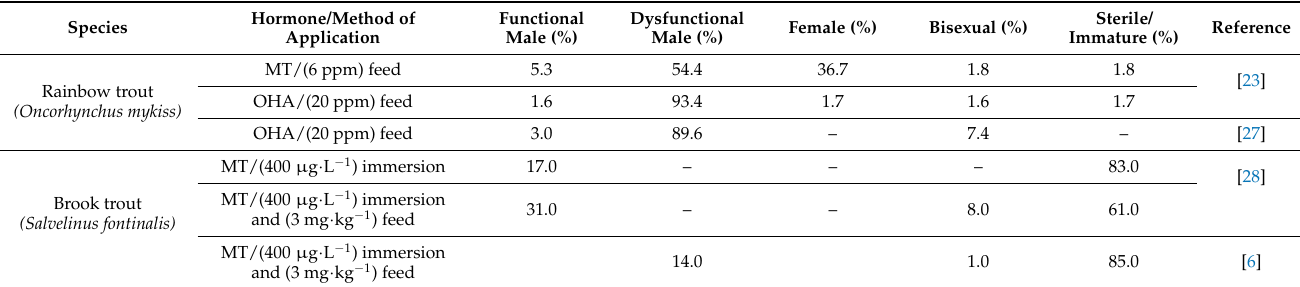
Table 1. Examples of the development of the reproductive system in a salmonid sex-reversed female population after hormonal treatment.